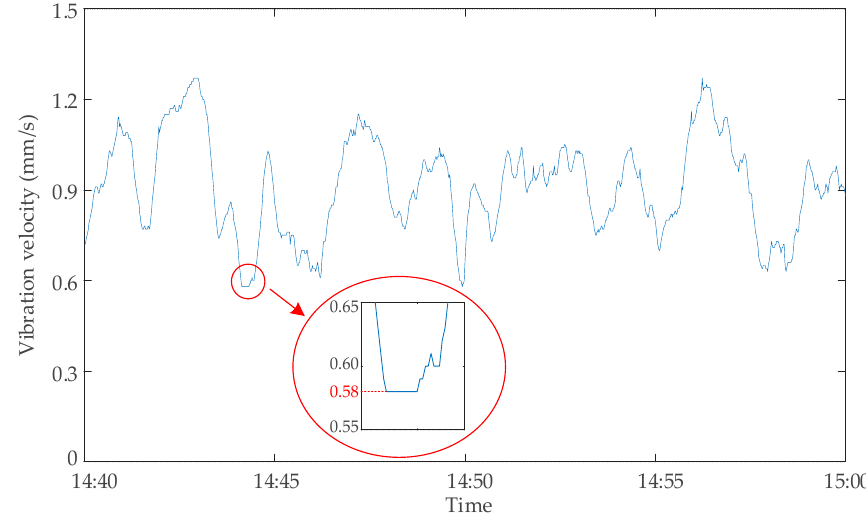
Figure 12. Monitoring data of vibration velocity of transformer C on 28 April 2020.